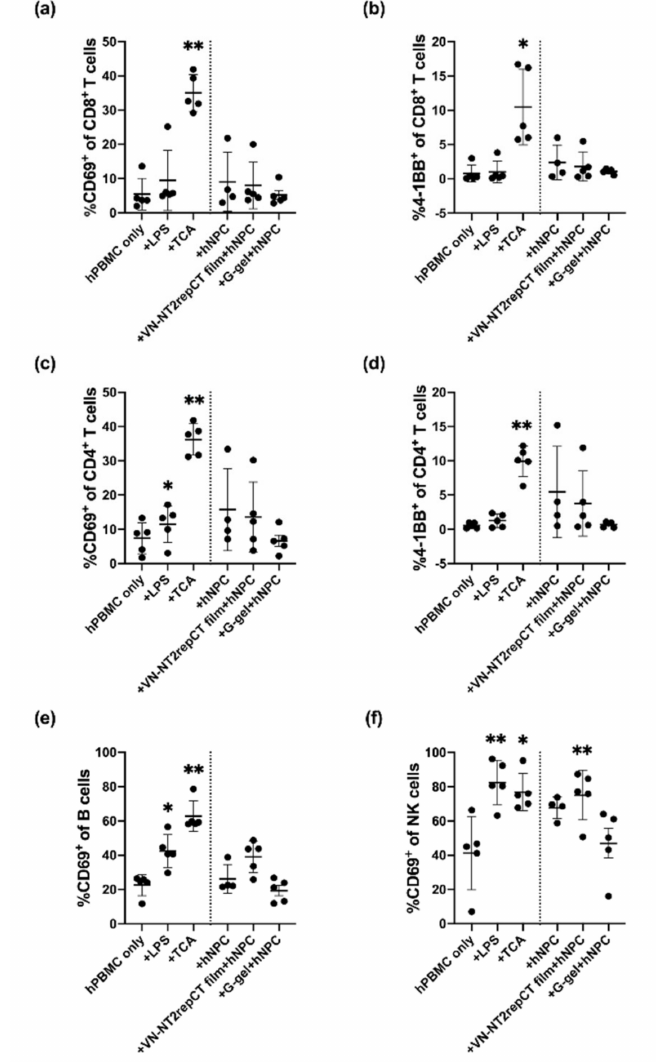
Figure 4. Activation of hPBMC subpopulations after co-culture with allogeneic NPCs with or without the presence of VN–NT2RepCT film or granular HA hydrogel. Human PBMCs were cultured as: hPBMC-only (baseline control); (hPBMCs) + LPS (positive control); (hPBMCs) + TCA (positive control); (hPBMCs) + cell suspension of hNPCs (“hNPCs”); (hPBMCs) + cell suspension of hNPCs with VN–NT2RepCT film (“VN–NT2RepCT film + hNPCs”) or (hPBMCs) + granular HA hydrogel with hNPCs encapsulated. After 15–18 h in culture, the expression of the activation markers CD69 and 4-1BB was analyzed by flow cytometry. The percentages (%) of hPBMC subpopulations ( a ) of CD69 + out of all CD8 + T cells; ( b ) of 4-1BB + out of all CD8 + T cells; ( c ) of CD69 + out of all CD4 + T cells; ( d ) of 4-1BB + out of all CD4 + T cells; ( e ) of CD69 + out of all B-cells; and ( f ) of CD69 + out of all NK cells. Data are presented as mean ± SD, and each dot within a group represents hPBMCs from one biological donor. The vertical dotted line in the graph demarcates the control versus the experimental groups. The statistical test of mixed-effects analysis with Dunnett’s post hoc test was applied to compare the experimental groups with the hPBMC-only group. Statistically significant differences from the hPBMCs-only group are indicated as: * p ≤ 0.05, ** p ≤ 0.01. n = 5 biologically different hPBMC populations. Abbreviations: SD, standard deviation; TCA, T cell activation; G-gel, granular HA hydrogel. However, when cell suspensions of hNPCs were co-cultured with VN–NT2RepCT film, the proportion of CD69 + NK cells (75.2% ± 14.5%, p = 0.0032) increased